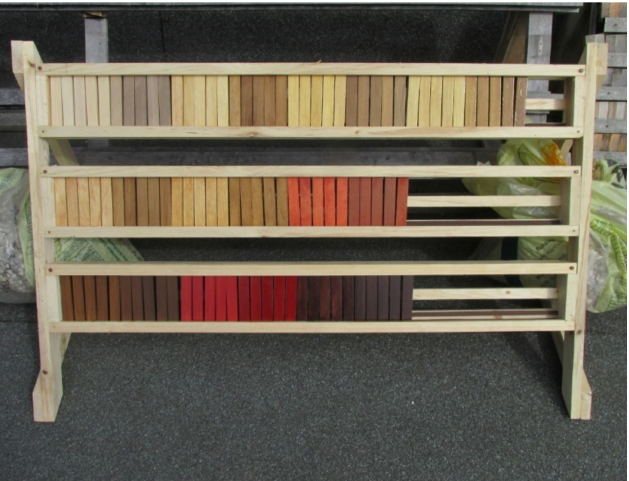
Figure 1. Weather exposure of untreated and acetylated hornbeam wood coated with various oils and